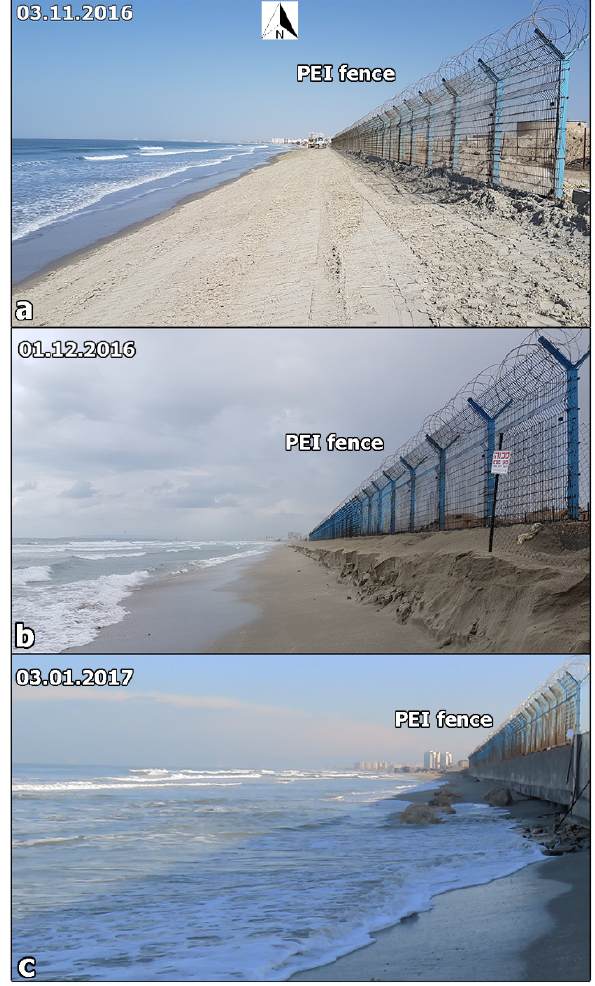
Figure 7. The sandy beach along the southern part of PEI fence: ( a ) after nourishment; ( b ) one month later; ( c ) two months after nourishment.